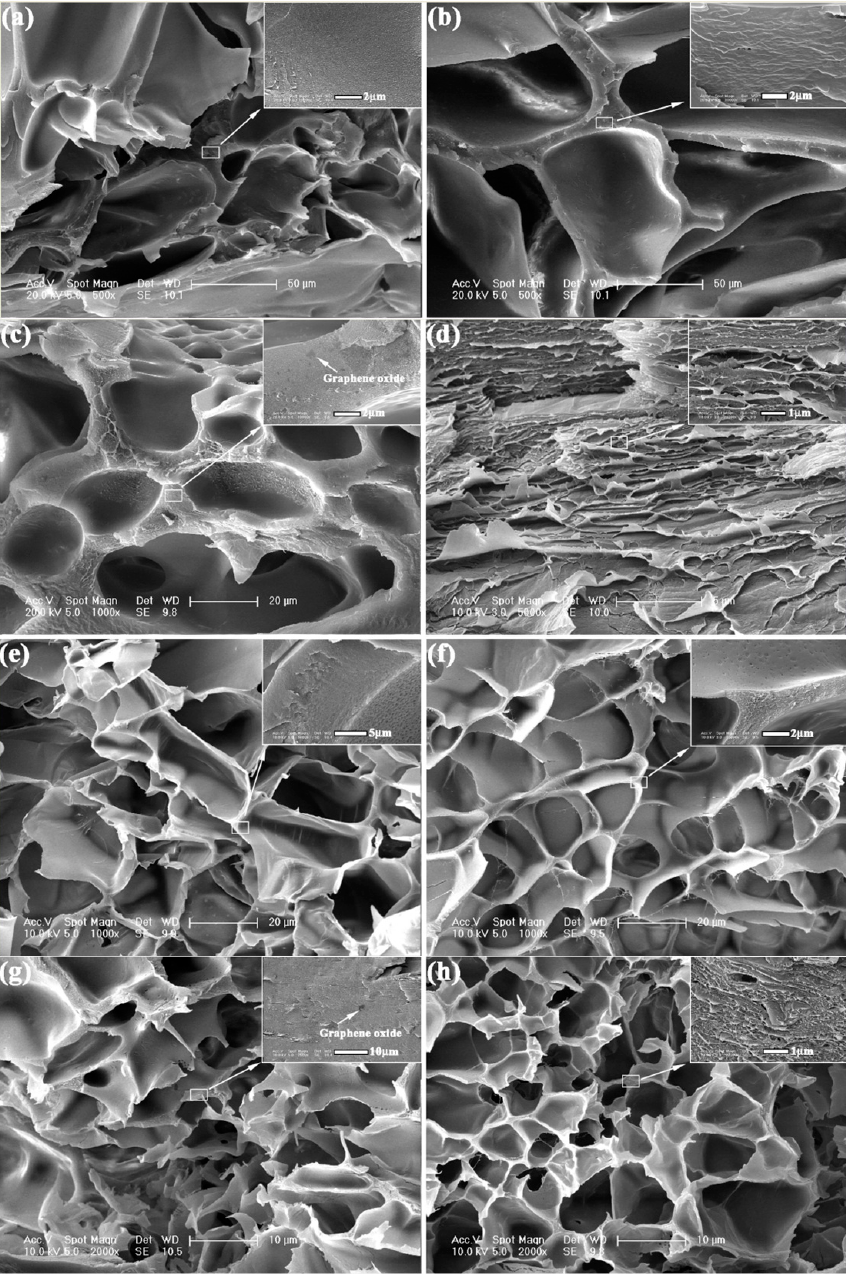
Figure 2. Microstructure of PDMAA hydrogels with various GO contents ( a ) 0 mg/mL; ( b ) 1 mg/mL; ( c ) 2 mg/mL; and ( d ) 3 mg/mL and PNIPAm hydrogels with various GO contents; ( e ) 0 mg/mL; ( f ) 1 mg/mL; ( g ) 2 mg/mL; and ( h ) 3 mg/mL.